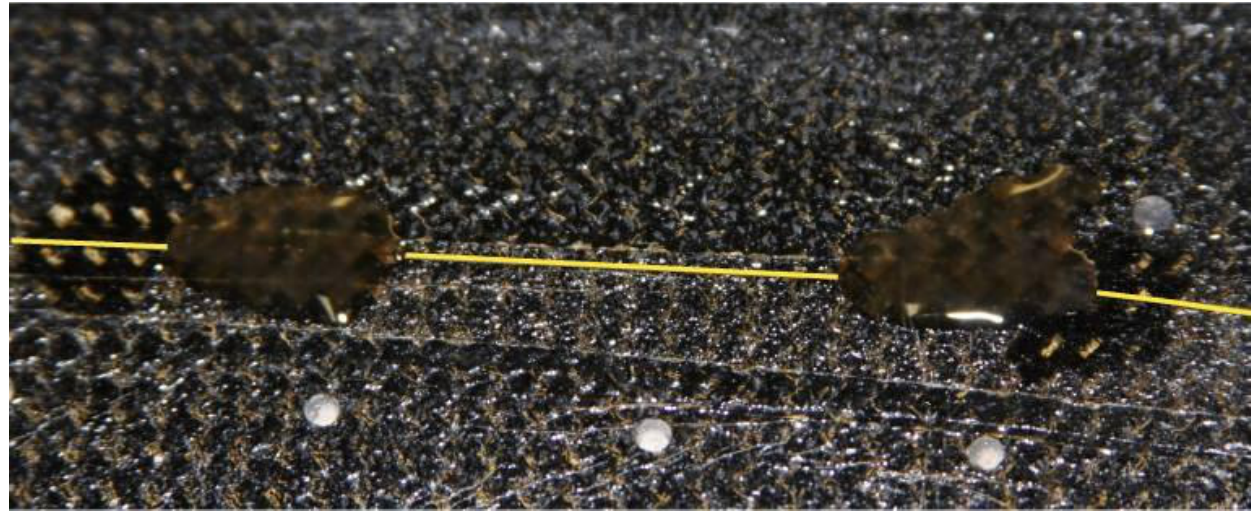
Figure 2. Detail of an installed Fiber Bragg Grating using epoxy as bond